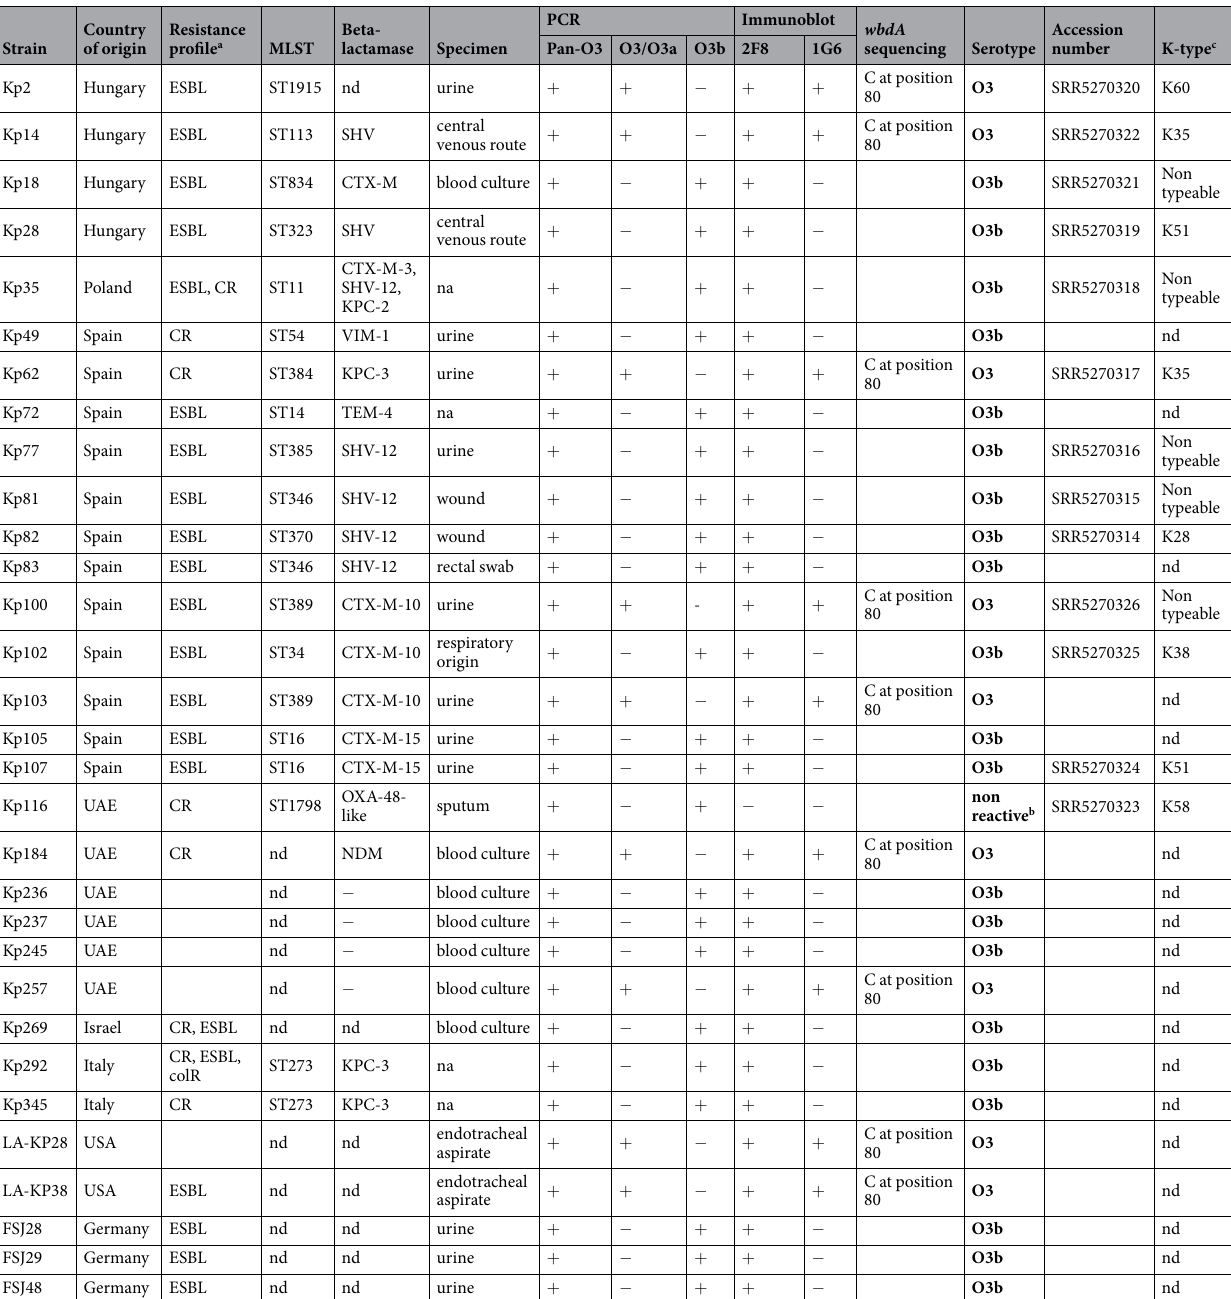
Table 2. Clinical isolates analyzed in the study. a Only ESBL production (ESBL), carbapenem resistance (CR) and colistin resistance (colR) indicated. b Despite a low amount of high-molecular weight